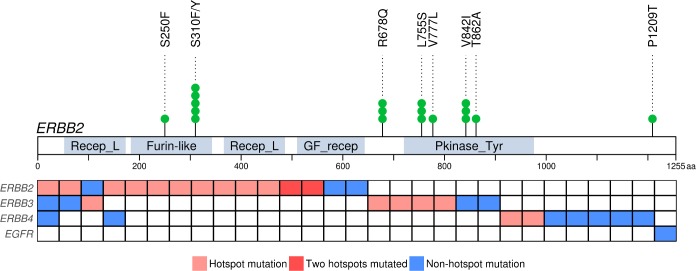
Mutation pattern in ERBB receptor family.Mutations in ERBB2 (ENST00000269571) grouped into four hotspots (top). Samples (n = 29) with a mutated member of ERBB receptor family are presented in columns (below). In addition to a hotspot mutation, some samples displayed simultaneously a non-hotspot mutation in the same gene, thus all mutations are not shown in the figure. Recep_L = Receptor L domain; Furin-like = Furin-like cysteine rich region; GF_recep = Growth factor receptor domain; Pkinase_Tyr = Protein tyrosine kinase.